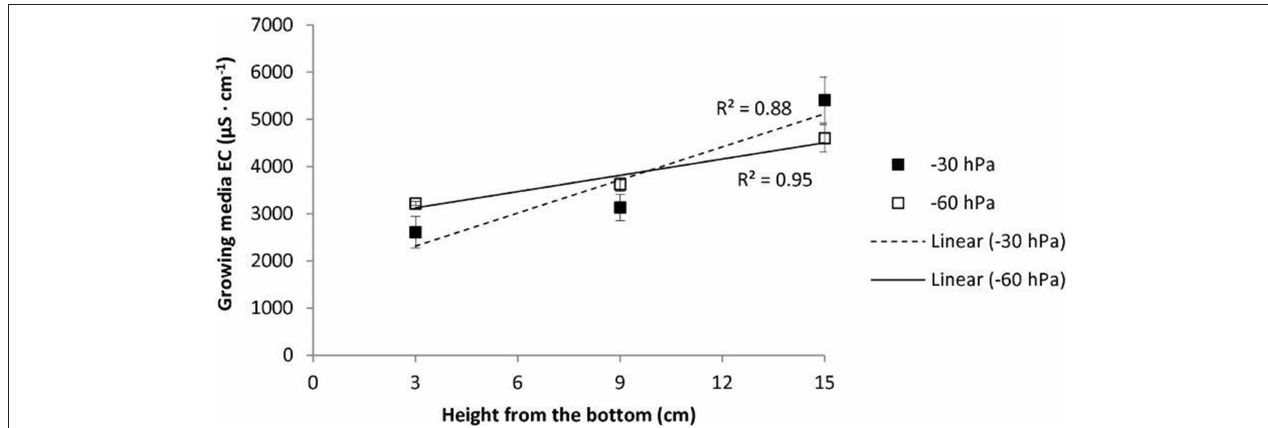
FIGURE 1 | Electrical conductivity (EC, 1:1.5 dilution method) at three layers of the vertical profile in subirrigated soilless substrates with constant − 30 or − 60 hPa matric potential irrigation set-point (vertical bars indicate ± S.E. of means).